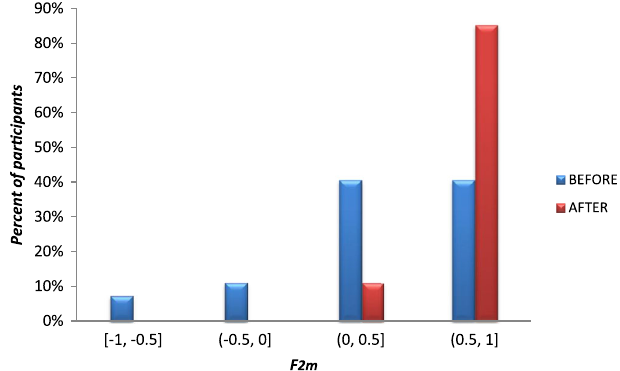
FIG. 1. Distribution of F 2 m before and after the course.